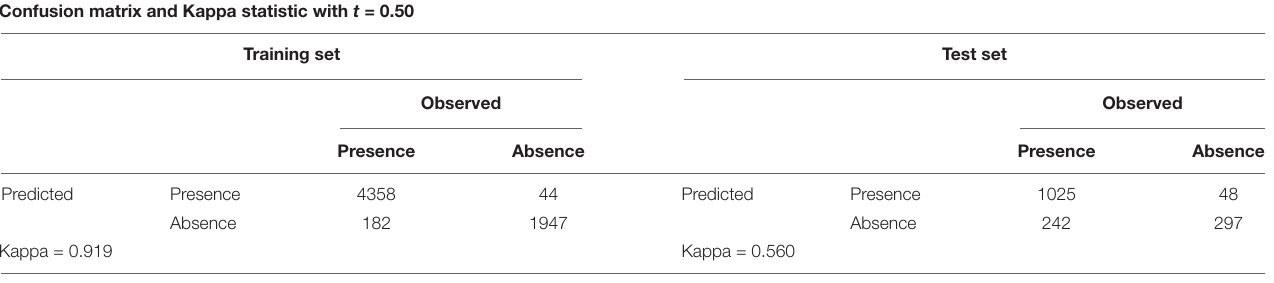
FIGURE 3 | ROC curves of the best RF trained with the AUC for both the training (A) and the test set (B) . The optimal cut-off, represented by the red dot in the Figure 3B , was calculated on the analysis of the ROC curve based on the test set. TABLE 2 | Confusion matrices and Kappa statistics for the RF output before and after the optimization of the cut-off value. Confusion matrix and Kappa statistic with t =